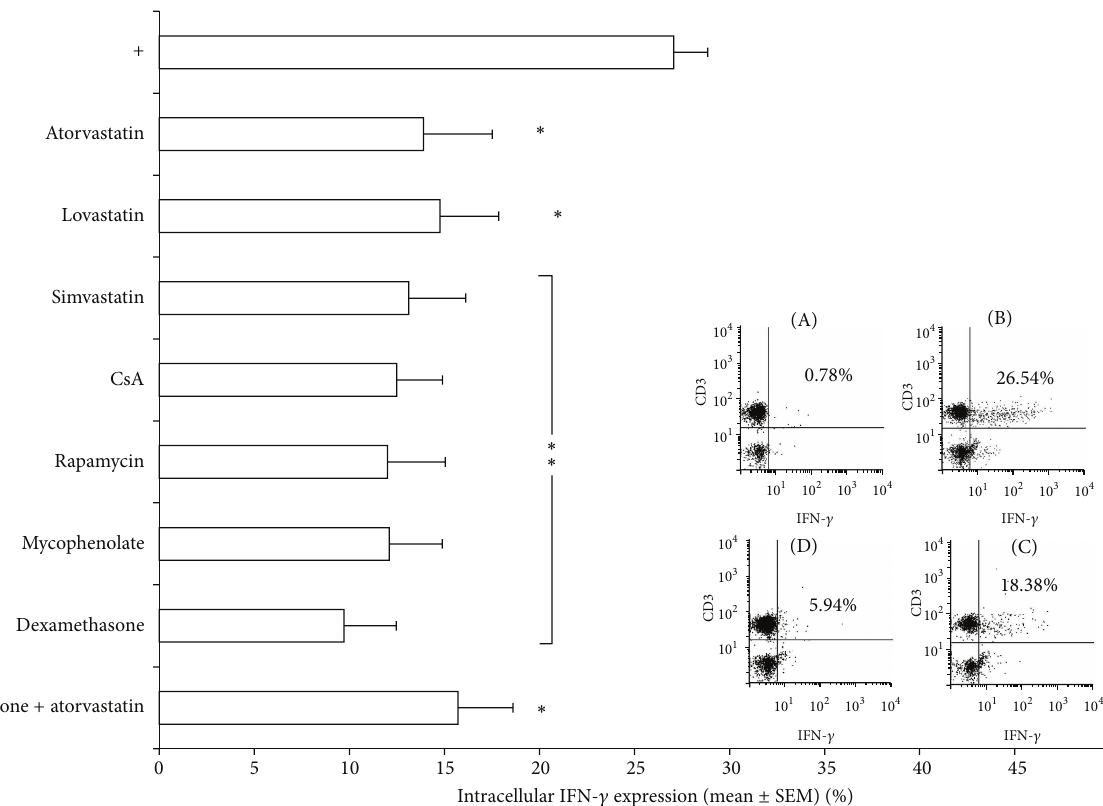
Figure 5: Percentage of IFN- 𝛾 expression in PMA/ionomycin stimulated whole blood with or without addition of drugs. Each bar represents the means ± SEM from 6 experiments, each performed in triplicate, subtracting basal cytokine expression. Drug concentrations: atorvastatin (50 𝜇 M), lovastatin (50 𝜇 M), simvastatin (100 𝜇 M), rapamycin (100 𝜇 M), mycophenolate (100 𝜇 M), CsA (100ng/mL), and dexamethasone (400 𝜇 g/mL). ∗ 𝑃 < 0.05 ; ∗∗ 𝑃 < 0.01 . One representative FACS analysis is shown. (A), Unstimulated CD3 + T cells showing basal IFN-